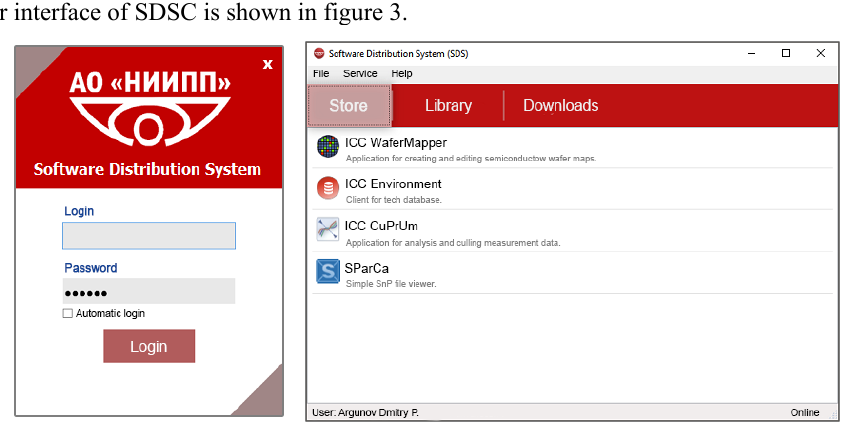
Fig. 3. SDSC user